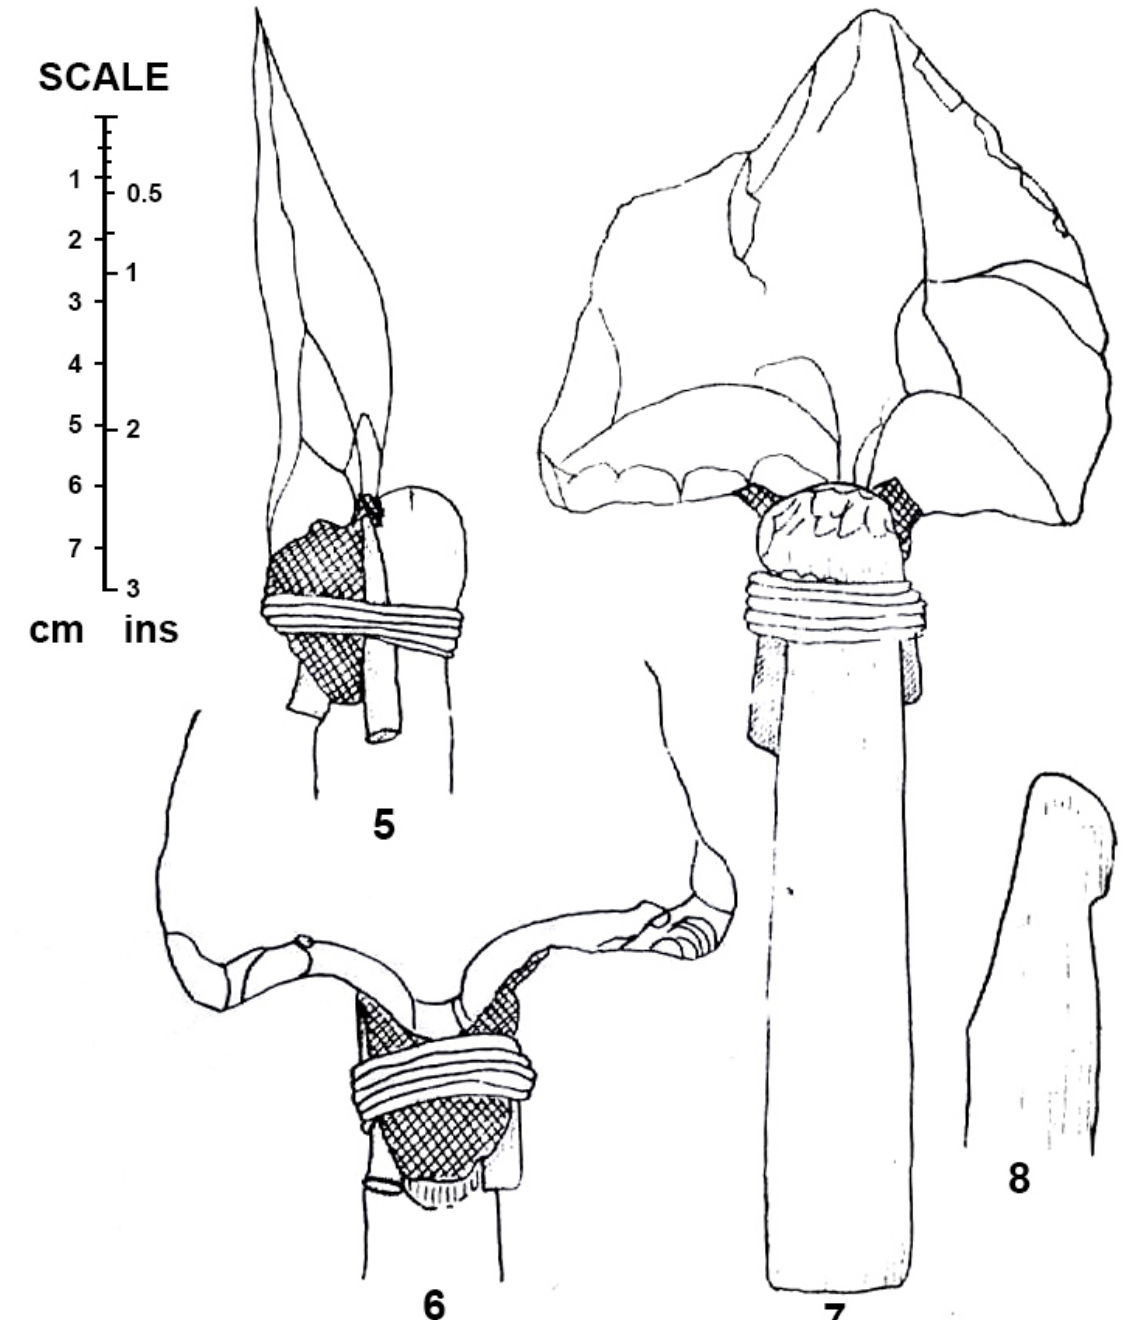
Figure 9. Line drawing of a possible hafting technique (with wedges and cord) for a Pointed variety (by Feachem, after Feachem 1947: fig. 58 No.